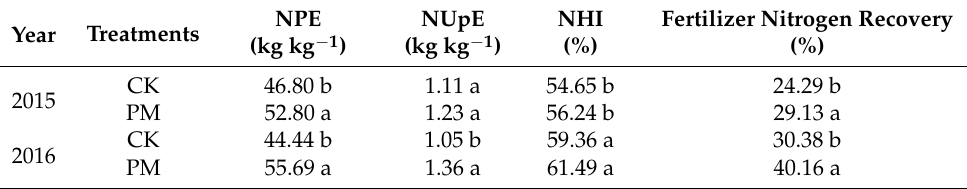
Table 1. Nitrogen efficiency under mulching and non-mulching in 2015–2016.